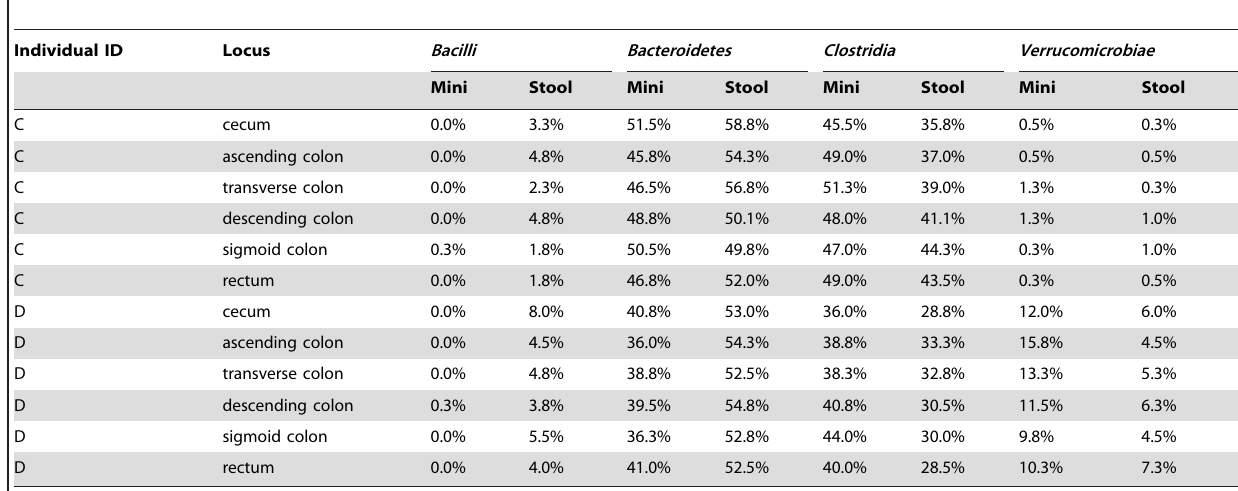
Table 1. Proportion of the top 4 bacterial classes in the six biopsies of two individuals by different extraction kits (Mini Kit and Stool Kit).